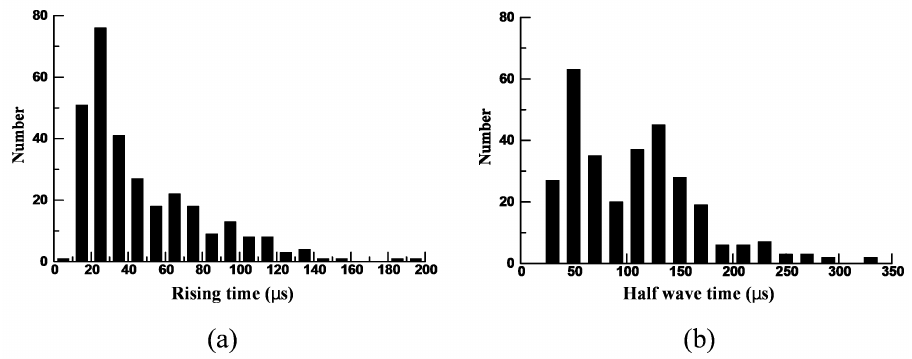
Figure 12. Distribution of rising time and half wave time. ( a ) Rising time; ( b ) half wave